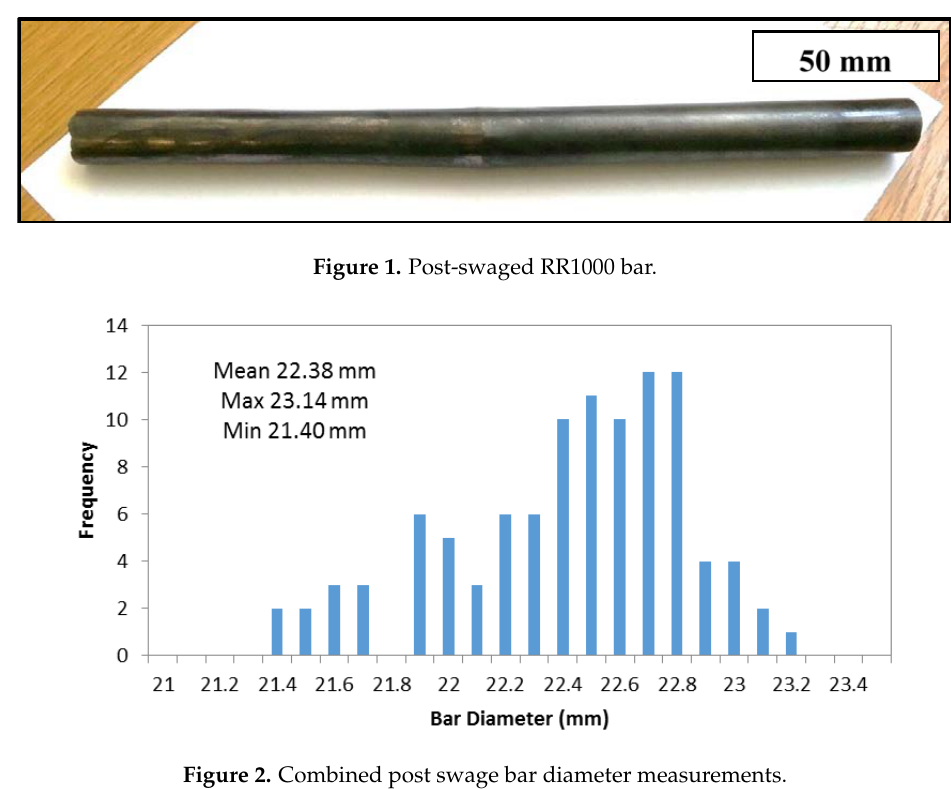
Figure 2. Combined post swage bar diameter measurements.